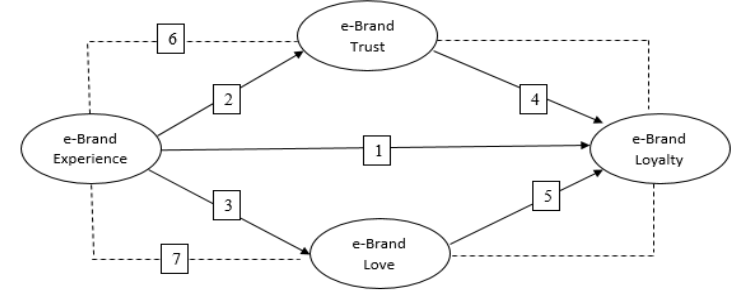
Figure 1 : Research Framework and